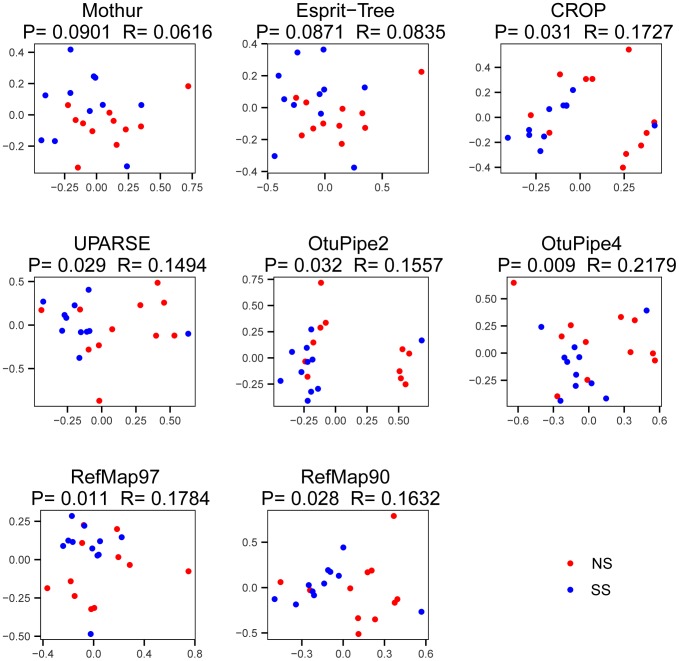
Non-metric multidimensional scaling plots of the distances for 22 fecal samples based on the different OTU matrices.Mothur, Esprit-Tree, CROP, UPARSE and Otupipe were used to bin 16S pyrotags into OTUs. Otupipe2 and Otupipe4 matrices were generated with MinSize parameter set to 2 or 4, respectively. In addition, 16S pyrotags were mapped into against a full-length 16S reference dataset to generate OTU matrices at 97% (RefMap97) or 90% (RefMap90) identity. The plots contain data from super-shedders (SS) and non-shedders (NS). ANOISM was used to test for similarities between SS and NS steers, generating correlation (R) and significance (p) values.